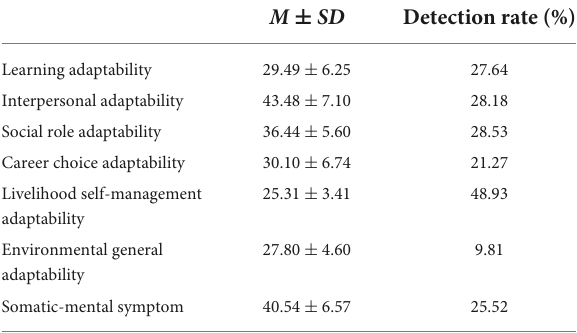
TABLE 1 The mean (M), standard deviation (SD), and detection rate of undergraduates’ maladjustment to university.